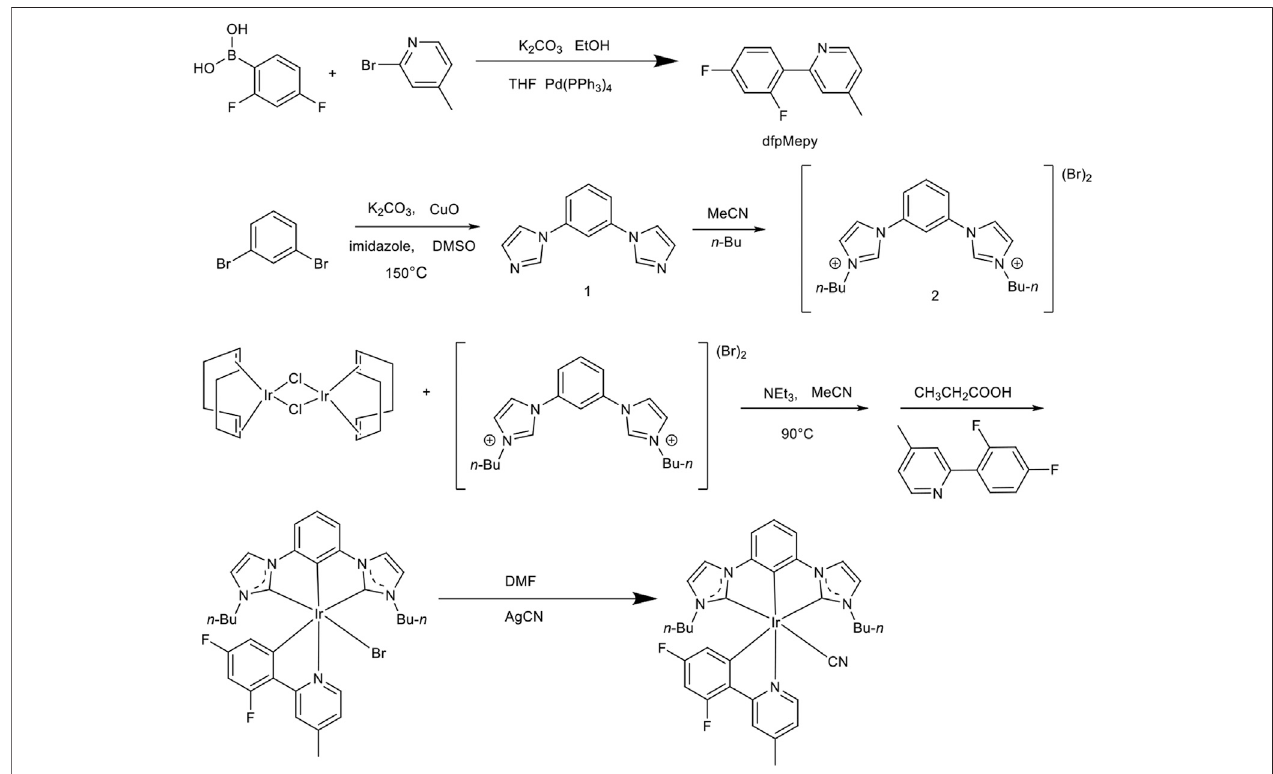
FIGURE 1 | Synthetic route and chemical structure of the Ir-dfpMepy-CN with [3+2+1] conformation.